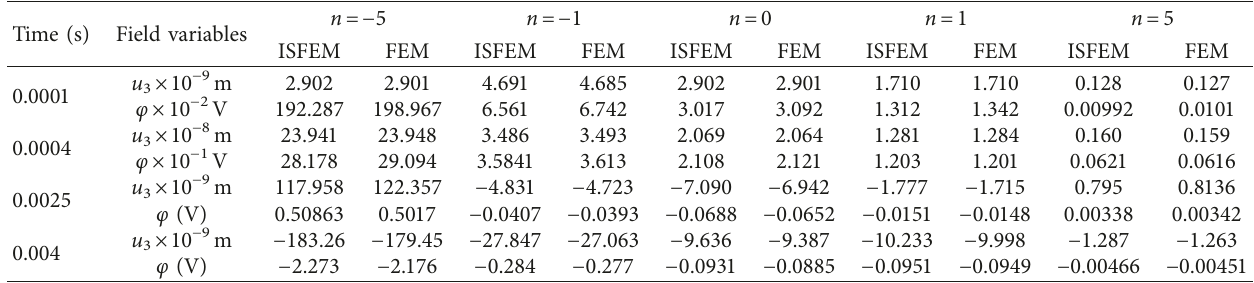
Table 5: Displacement u 3 and electrical potential φ at the loading point with the gradient parameter n based on PZT-5H under cosine load.